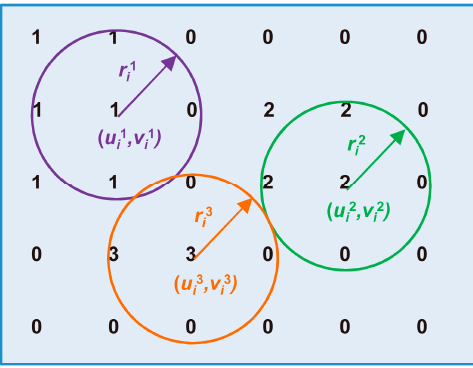
Figure 4. Illustration of the center and radius of each labeled connected component.